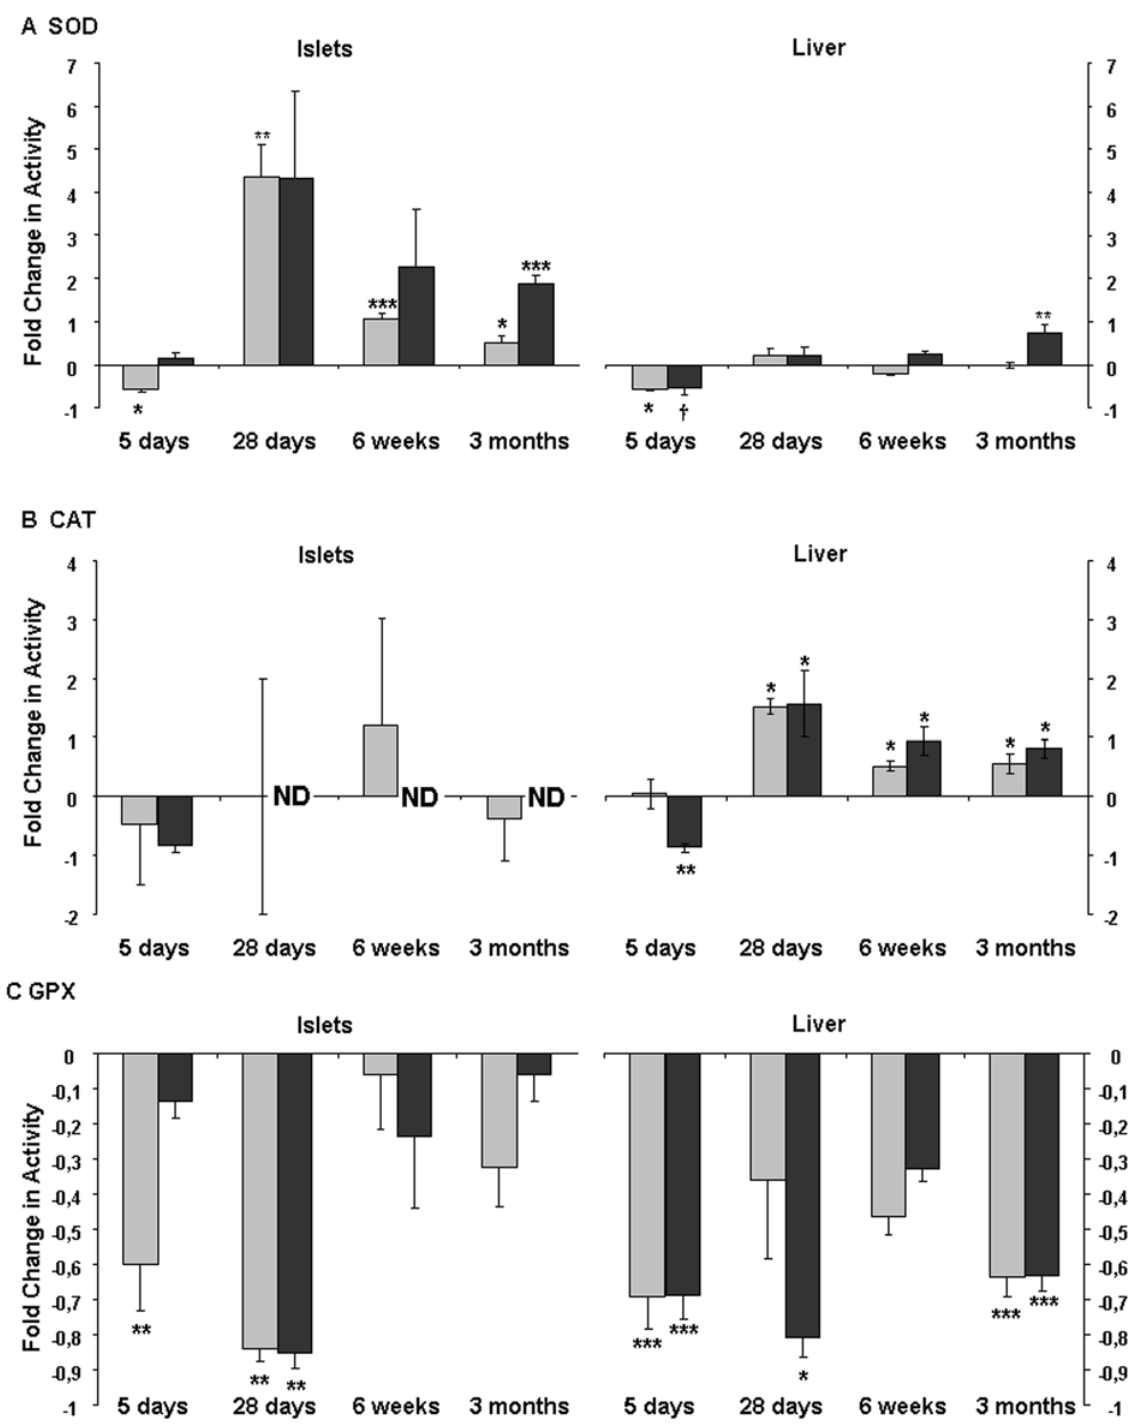
Figure 4. Postnatal effect of low protein diet on antioxidant enzyme activity in pancreatic islets and liver, in LP (grey) and LPT (black) progeny. (A) SOD, (B) CAT, (C) GPX. Data are expressed as fold change in activity relative to C; n=4–7 independent experiments. *p , 0.05, **p , 0.01, ***p , 0.001, { p=0.06 vs controls.